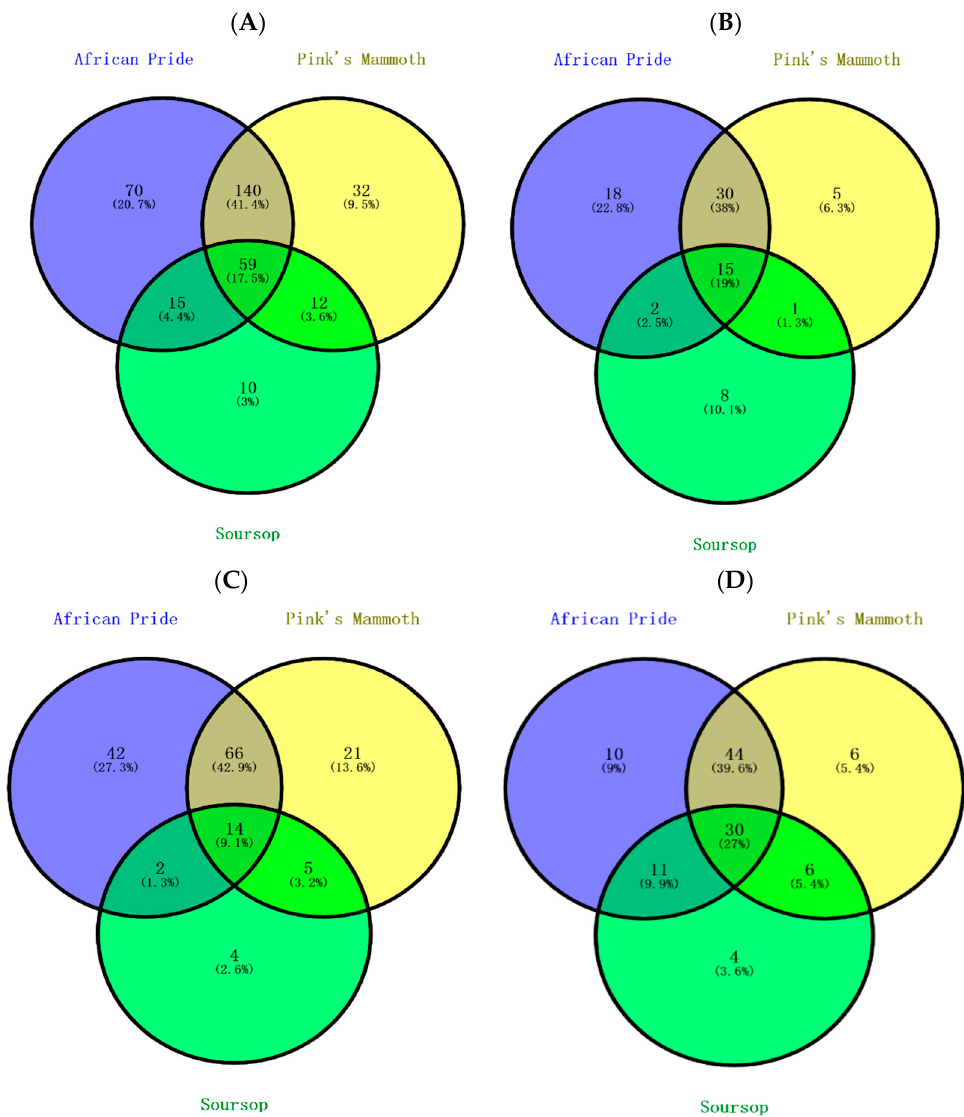
Figure 1. Venn diagram of the distribution of phenolic compounds in various custard apple varieties. The relations of ( A ) total phenolic compounds, ( B ) phenolic acids, ( C ) total flavonoids and ( D ) other phenolic compounds in three custard apples.